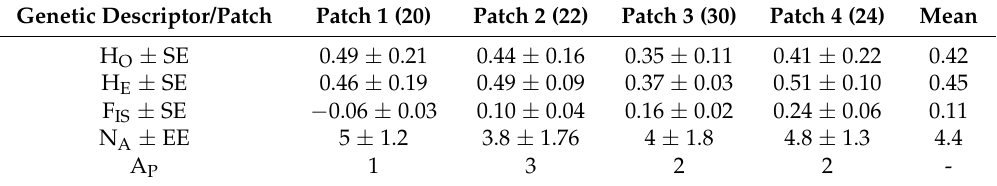
Table 2. Genetic diversity is described by patch based on the observed heterozygosity (H O ) and expected heterozygosity (H E ), inbreeding coefficient (F IS ), the mean number of alleles by locus (N A ), and the number of private alleles (A P ). SE = Standard Error. In parenthesis are the individuals sampled by patch. Genetic Descriptor/Patch Patch 1